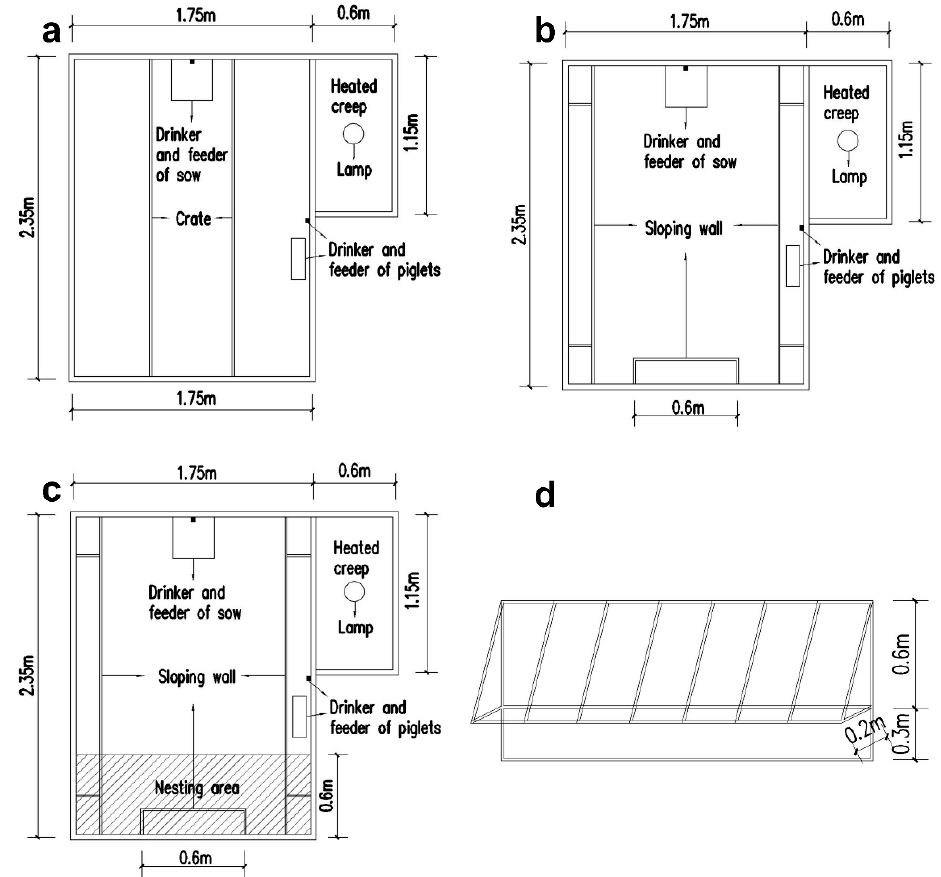
Figure 1. The diagram of the farrowing systems and the sloping wall. ( a ) Farrowing crate (FC); ( b ) Free farrowing pen with sloping walls (FFS); ( c ) Free farrowing pen with sloping walls and nest materials (FFSN); ( d ) Sloping wall.